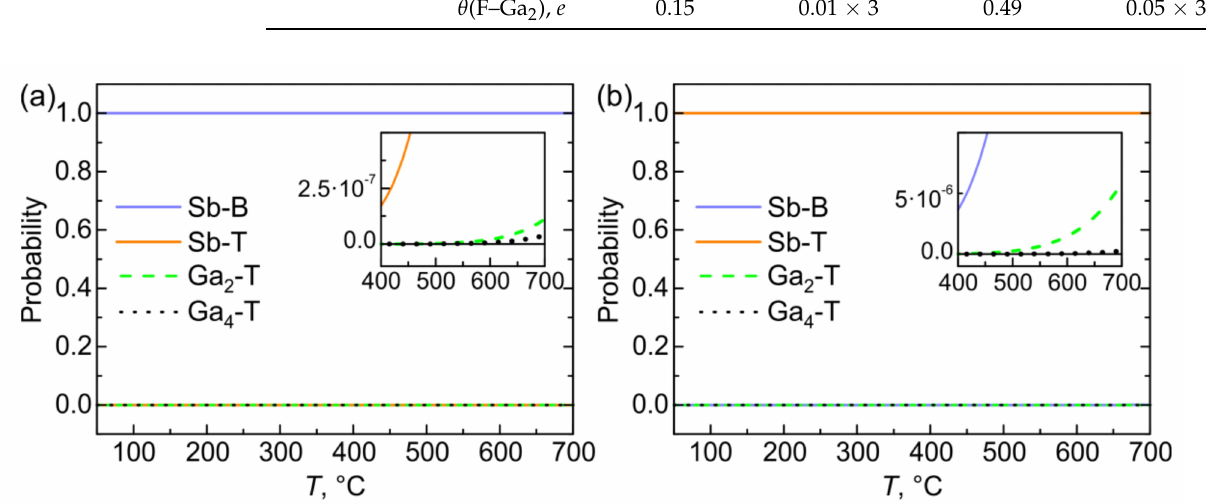
Figure 7. Probability of the oxygen ( a ) and fluorine ( b ) atom to be adsorbed in specific positions on the GaSb(111)B surface versus temperature. Inset graphs show the differences in probability given at higher